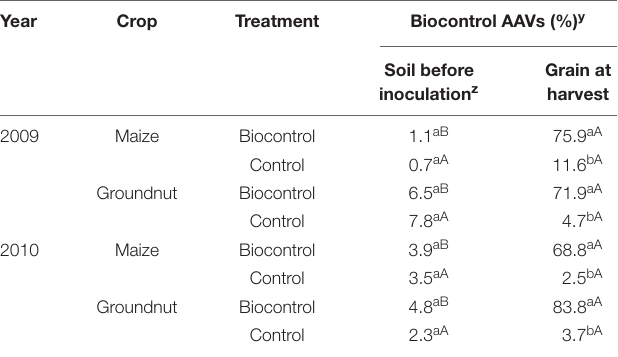
TABLE 4 | Incidence of atoxigenic African Aspergillus flavus vegetative compatibility groups (AAVs) active ingredients of a biocontrol product in soil before its application, and maize and groundnut grains from treated fields and control fields during 2009 and